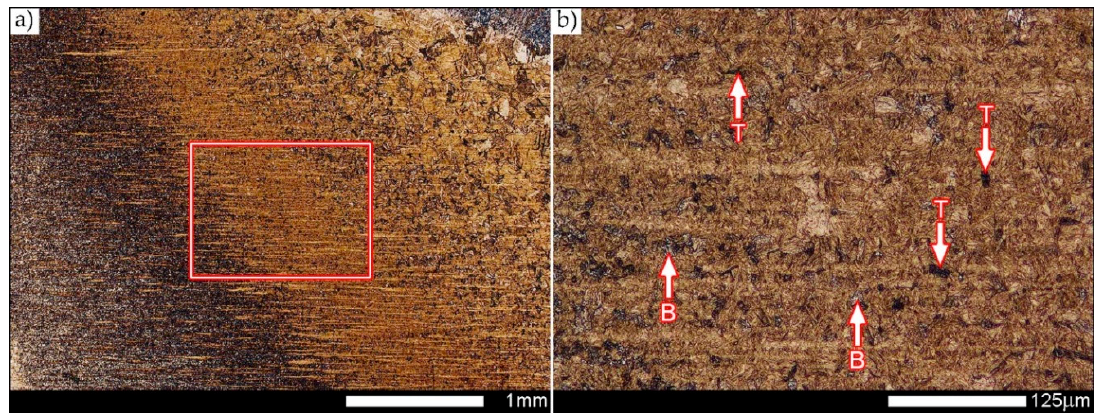
Figure 20. Microstructure of Hardox Extreme welded joint after welding: ( a ) in the area marked CGHAZ in Figure 5; ( b ) an enlarged image marked with frame in Figure 20a. Lath-like and locally acicular martensitic structure with bainite (B) on grain boundaries of former austenite. Light microscopy, etched with 2% HNO 3 .